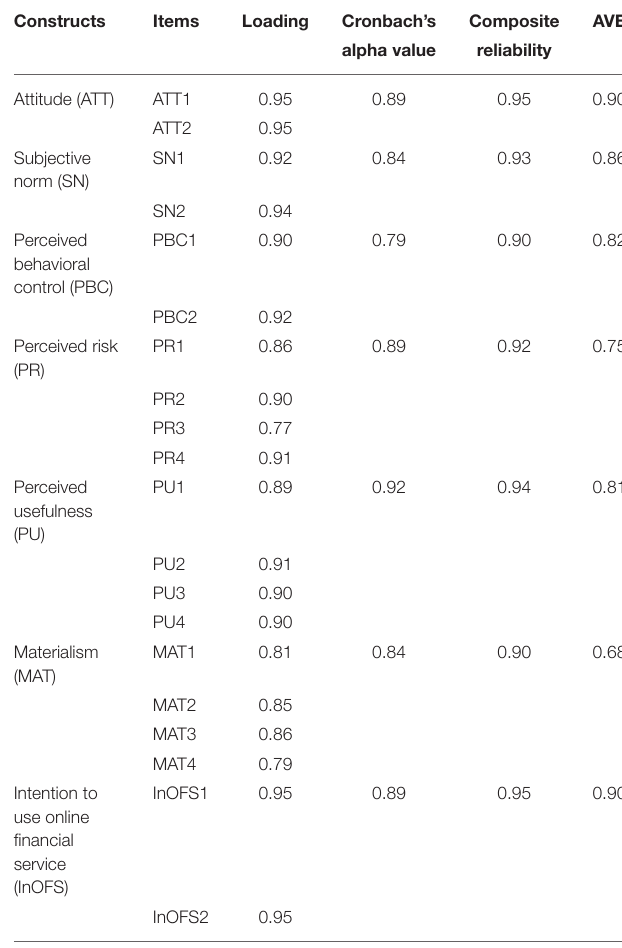
TABLE 3 | The correlations between constructs.